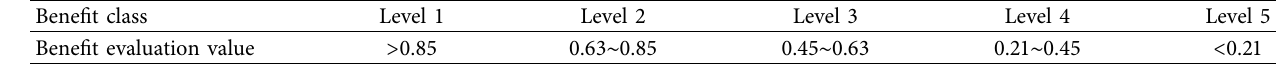
Table 4: Beneft grades of preventive maintenance of highway